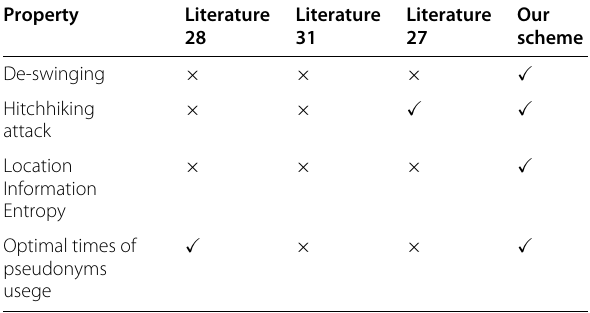
Table 4 Performance